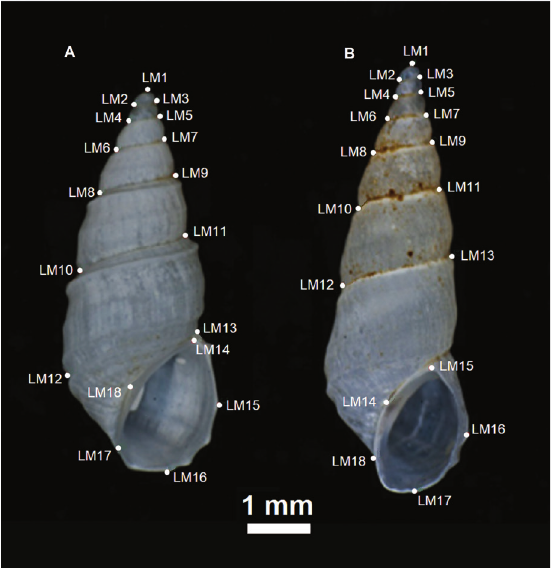
Figure 4. Dianella schlickumi and Dianella thiesseana specimens positioned with the axis of the shell on the y-axis and the aperture in the same plane as the objective, showing the location of the 18 landmarks (LM1-LM18) used. A D. schlickumi B D. thiesseana